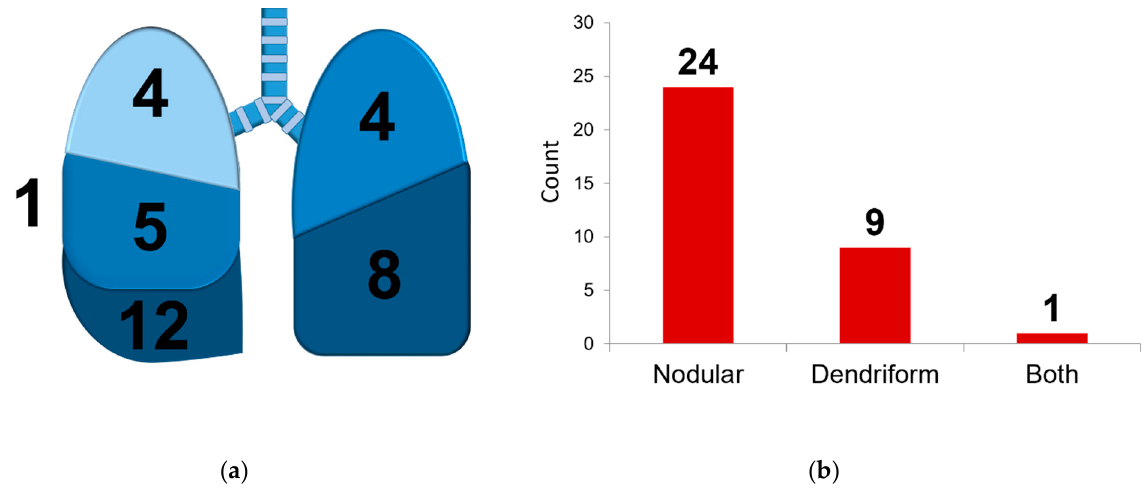
Figure 4. Anatomical and histological characteristics of PO described in this research article. Panel ( a ) shows the anatomical location in the different pulmonary lobes, with one ossification found in the subpleural space. Panel ( b ) shows the differentiation between nodular and dendriform ossification. One specimen contained both nodular and dendriform ossifications.